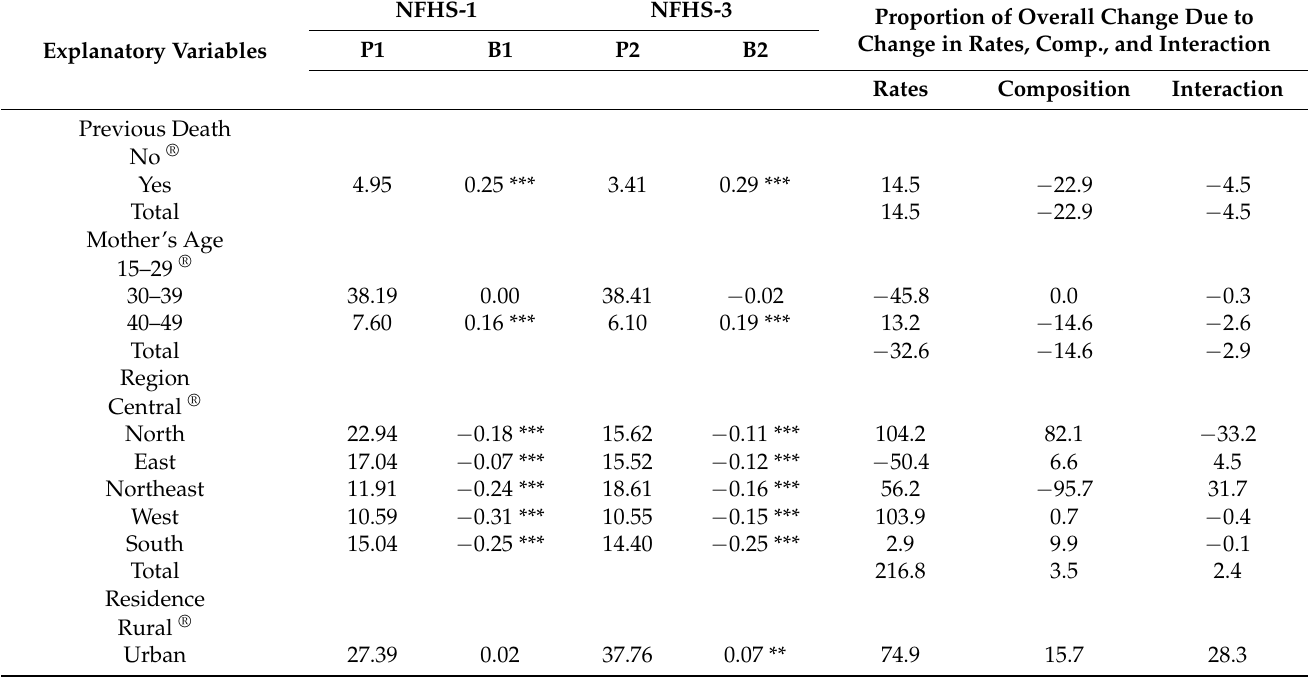
Table 6. Results of random effects dynamic probit model decomposition analysis of infant mortality into factors, India, 1992 and